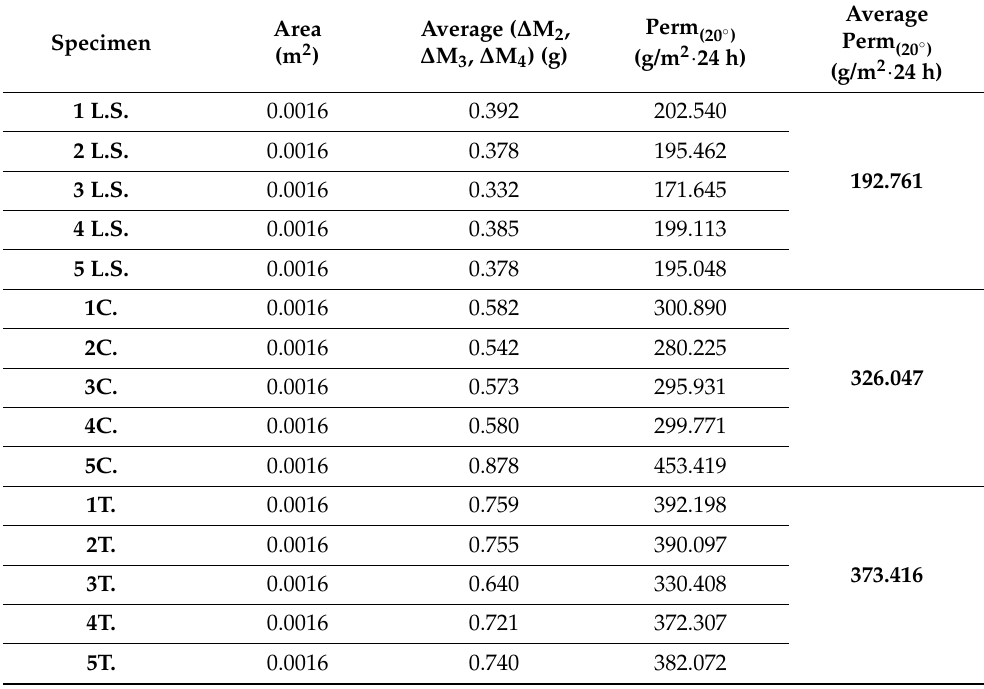
Table 1. Vapor permeability of Lecce Stone (L.S.), carparo (C.) and tuff